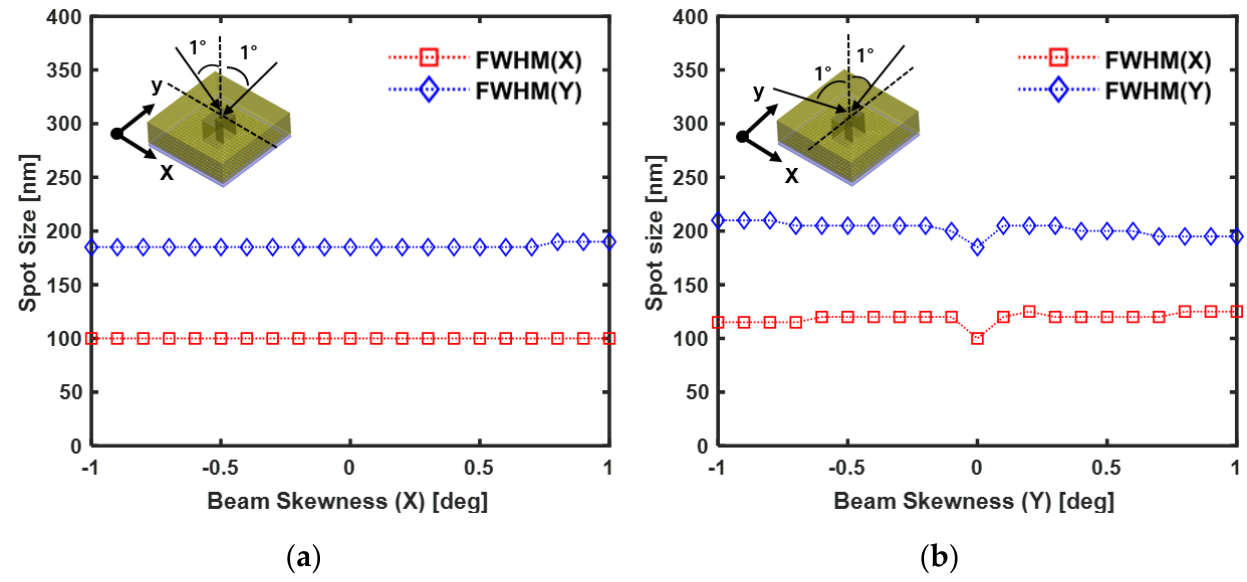
Figure 11. The calculated FWHM spot size on the bottom surface of the ZnS-SiO 2 layer due to beam skewness: ( a ) x -axis beam skewness ( − 1°~+1°); ( b ) y -axis beam skewness ( − 1°~+1°).